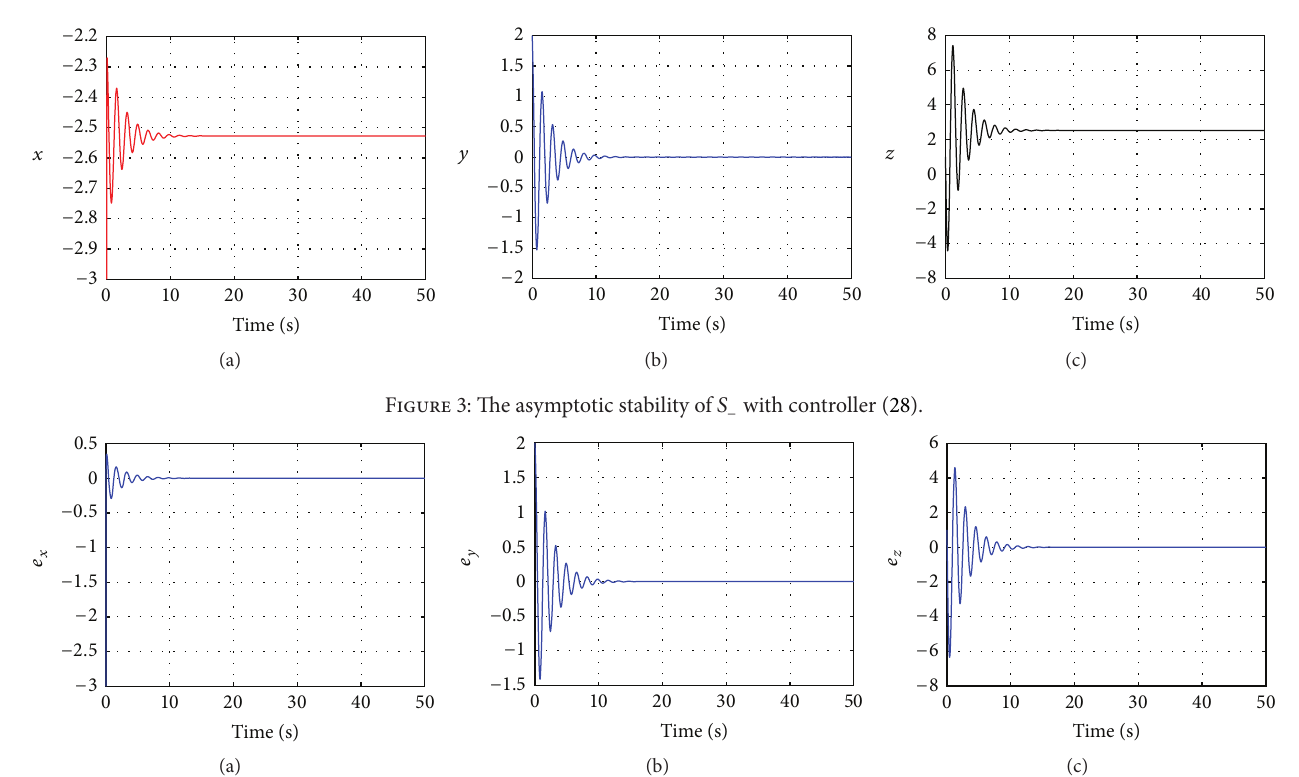
Figure 4: The synchronization errors of the system (39) and (40) with linear controller